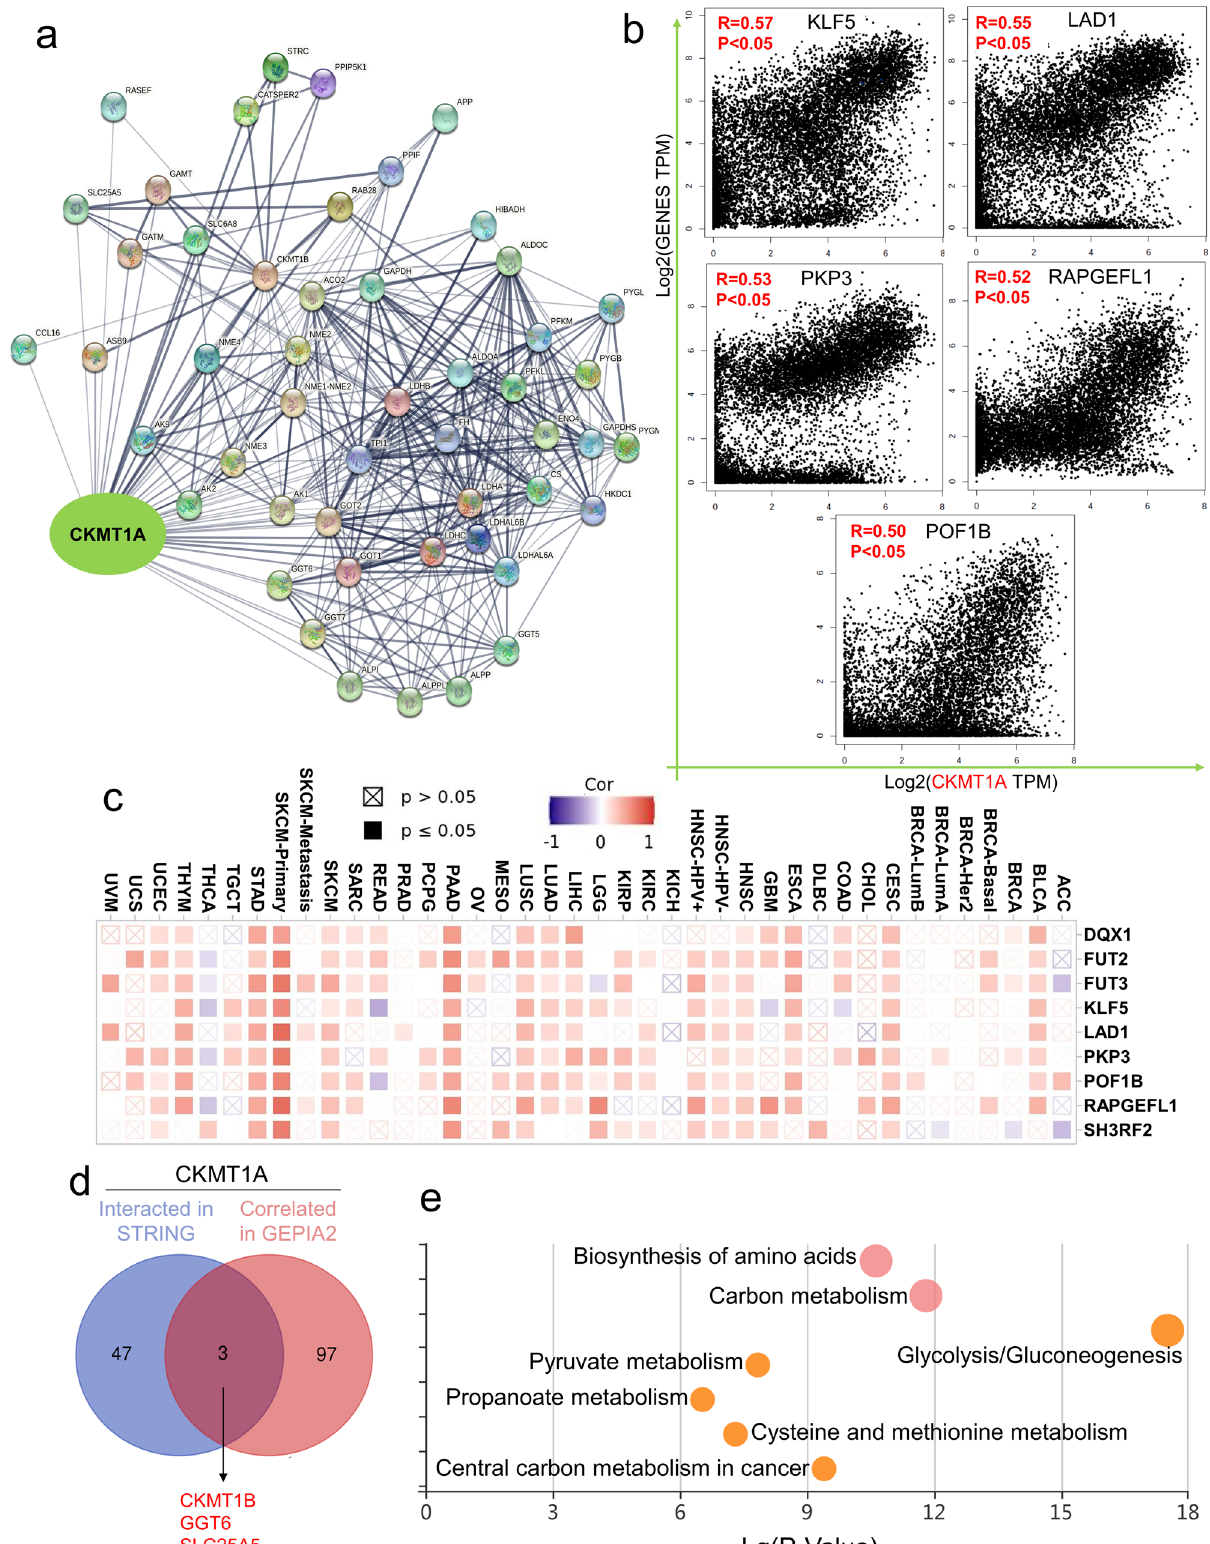
Figure 5. The enrichment analysis of CKMT1A-related genes. ( a ) The network of 50 CKMT1A-interacting proteins in the STRING tool. ( b ) The top 100 CKMT1A-correlated genes were obtained in TCGA projects and the expression correlation between CKMT1A and selected 5 genes, including KLF5, LAD1, PKP3, POF1B, and RAPGEFL1 were analyzed by GEPIA2 approach. ( c ) The heatmap of correlation between CKMT1A and selected top 10 genes, CKMT1B excluded, in different cancer types. ( d ) The Venn diagram of the CKMT1A interacted in STRING and correlated genes in GEPIA2. ( e ) The KEGG pathway analysis of CKMT1A-interacted and the correlated